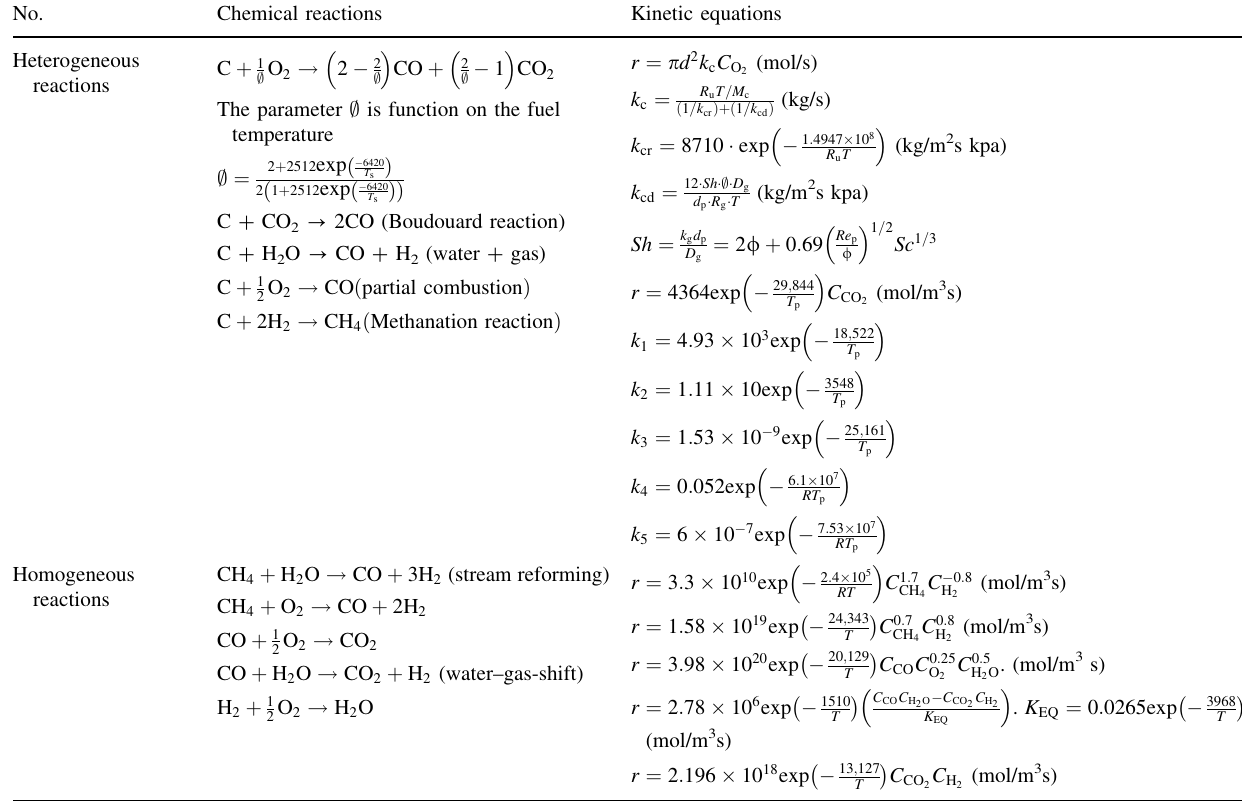
Table 6 Heterogeneous and homogeneous reactions in the fixed bed gasifier No. Chemical reactions Kinetic equations Heterogeneous reactions